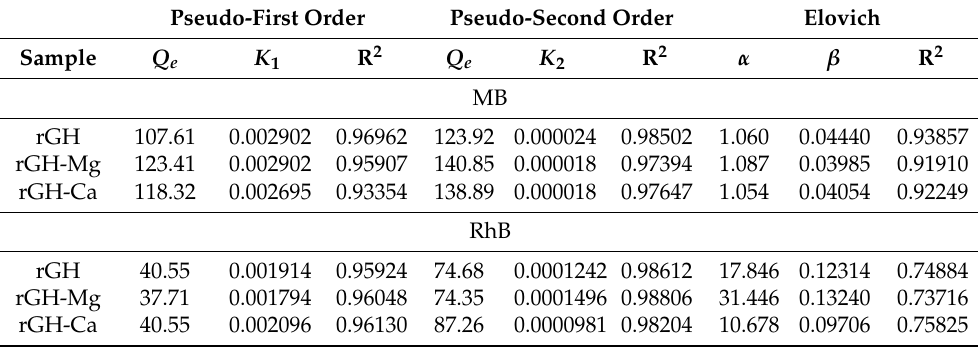
Table 5. Kinetic parameters obtained from the pseudo first-order (PFO), pseudo second-order (PSO) and Elovich kinetic model for the adsorption of MB and RhB. Pseudo-First Order Pseudo-Second Order Elovich Sample